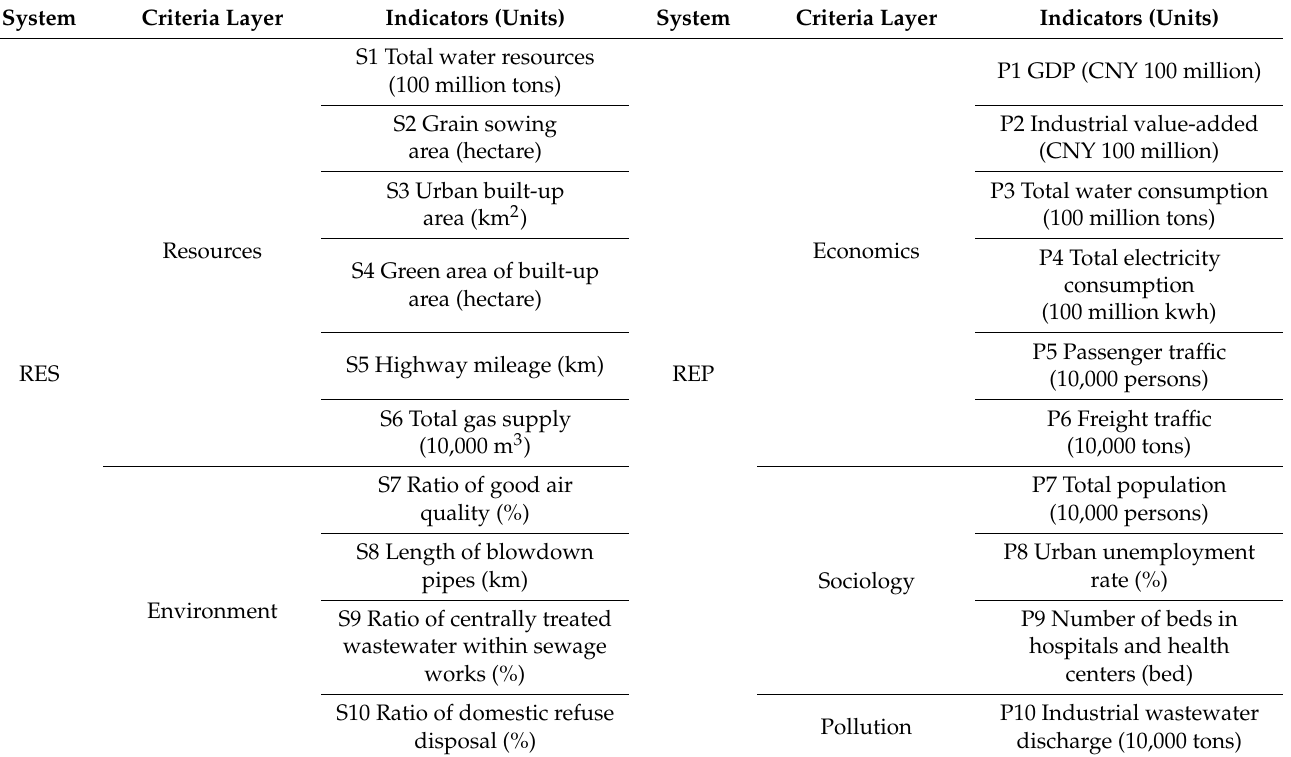
Table 1. Evaluation index system of